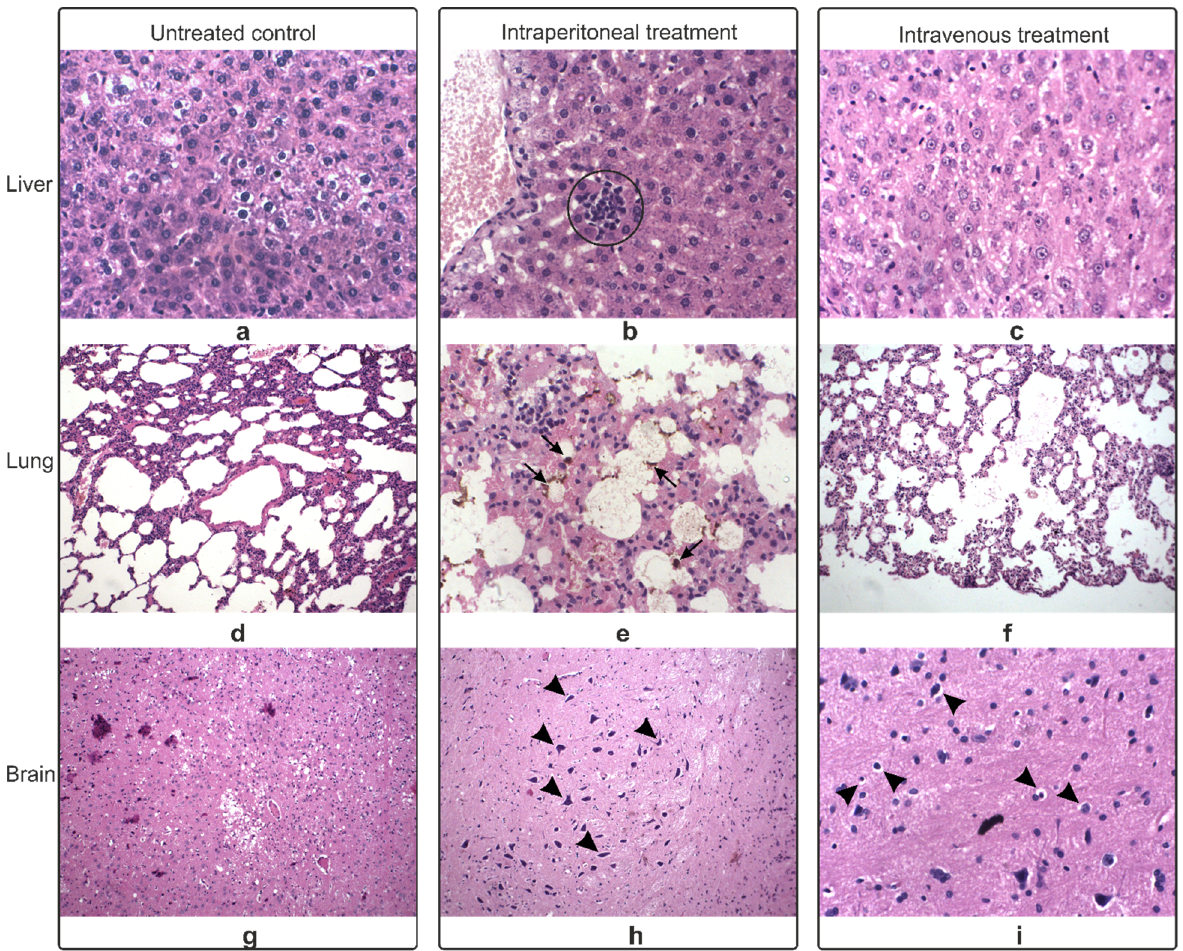
Figure 3. Histological examination of the liver ( a – c ), lung ( d – f ), and brain ( g – i ), harvested 24 h after intraperitoneal and intravenous administration of SPION-PEG clusters and compared to the untreated controls; circle = lymphocyte aggregates, arrows = ferric pigments, arrowheads = shriveled pyramidal neurons (h) and hypochromic nuclei (i); 40× magnification.